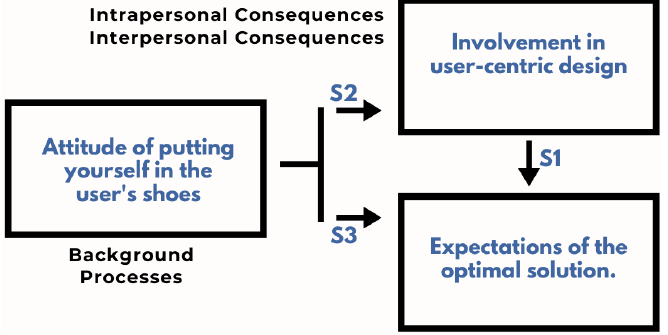
Figure 4. Conceptual model of empathy analysis constructed [elaborated by authors].